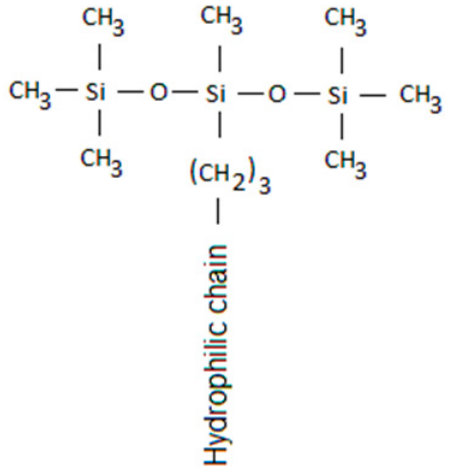
Figure 1. Structure of trisiloxane surfactants.